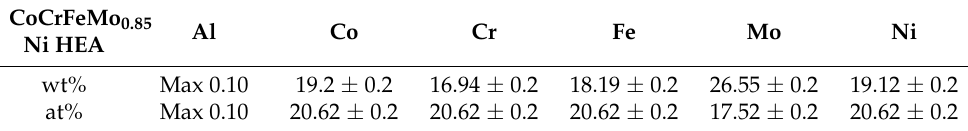
Table 1. Nominal compositions of as-received CoCrFeMo 0.85 Ni high entropy alloy